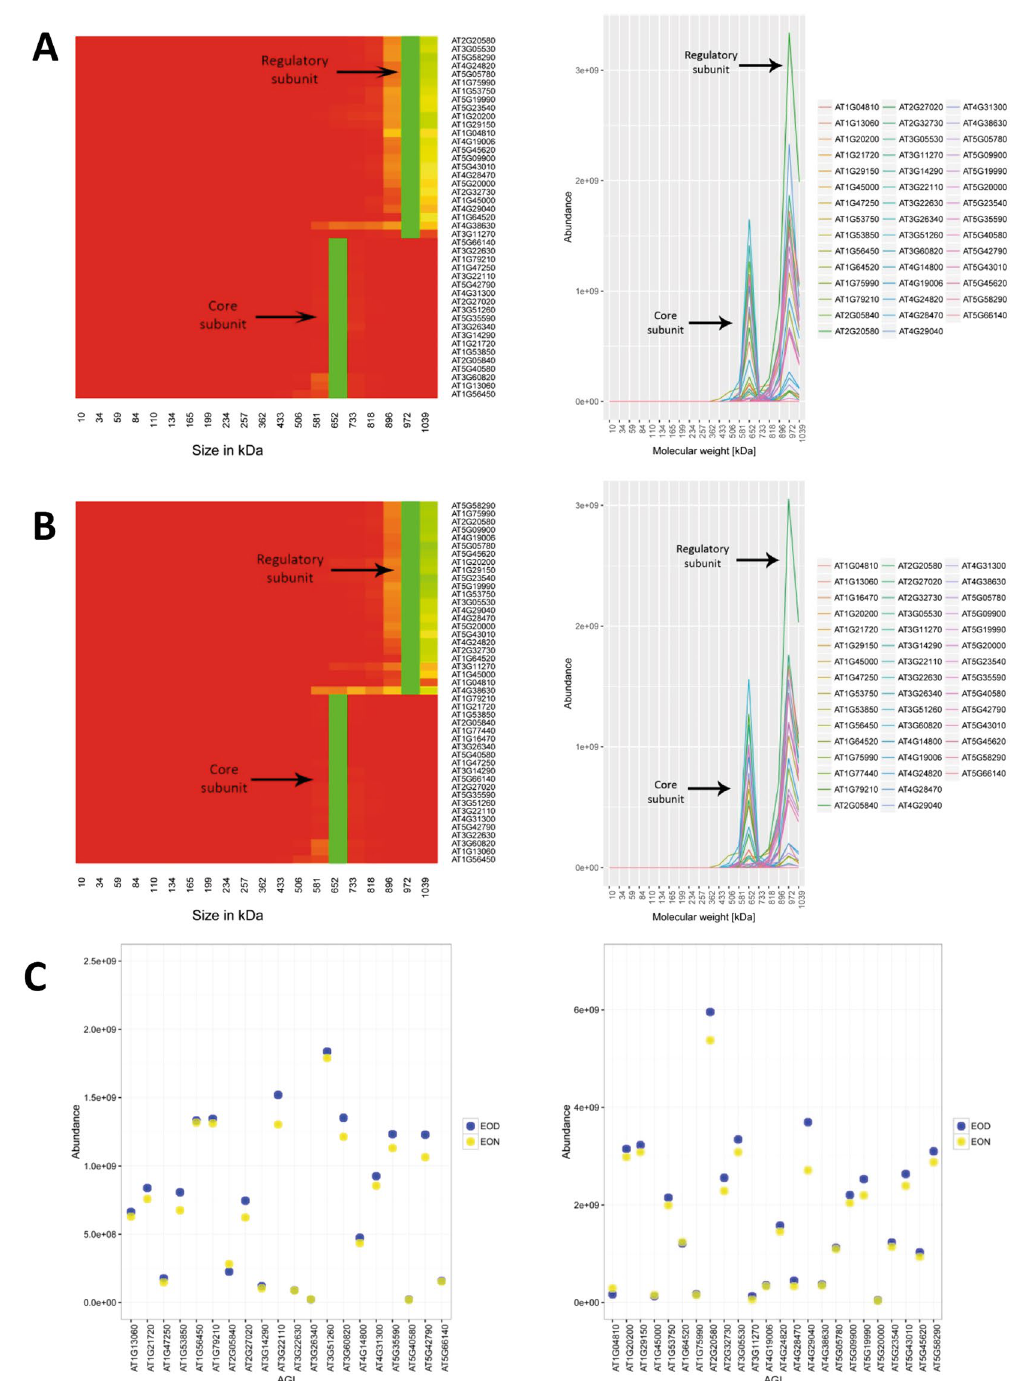
Figure 6. Comigration of the proteasomal subunit protein profiles. The protein profiles of the subunits comprising the proteasome complex were investigated at the ( A ) ED and ( B ) EN. Heatmaps shown represent the deconvoluted protein elution profiles of the proteins that belong to the regulatory and core subunits of the proteasome complex. The protein profiles were normalized to the maximum value. Green areas indicate the fraction where the highest abundance for a protein was observed. Comigration was observed for the constituents of the regulatory and core subunits of the proteasome complex. To the right of the heatmaps the protein elution profiles used to generate the respective heatmaps are shown. ( C ) A comparison of the protein abundance of the proteasomal proteins was performed at the ED and the EN. The total abundance for each of the proteins belonging to the core (left) and regulatory (right) subunits of the proteasome was compared between the two time points. The abundance of each of the proteins was summed across the fractions and are represented as yellow and blue circles for the ED and EN,